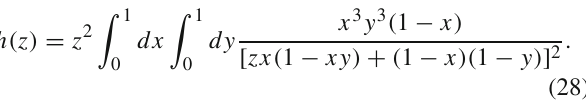
with g 3 the QCD coupling at the scale ∼ 1 GeV,